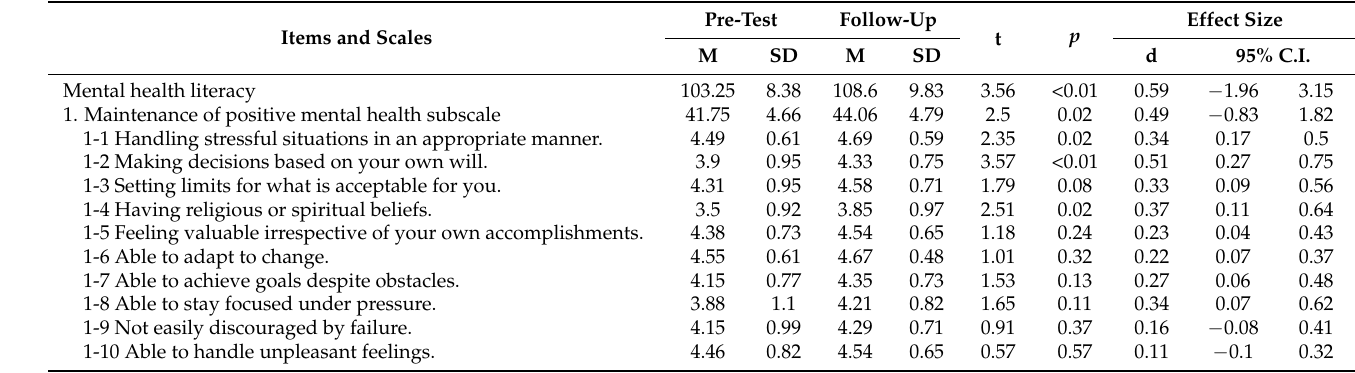
Table 4. Differences of mental health literacy, subscale and items scores between pre-test and follow- up surveys ( n =